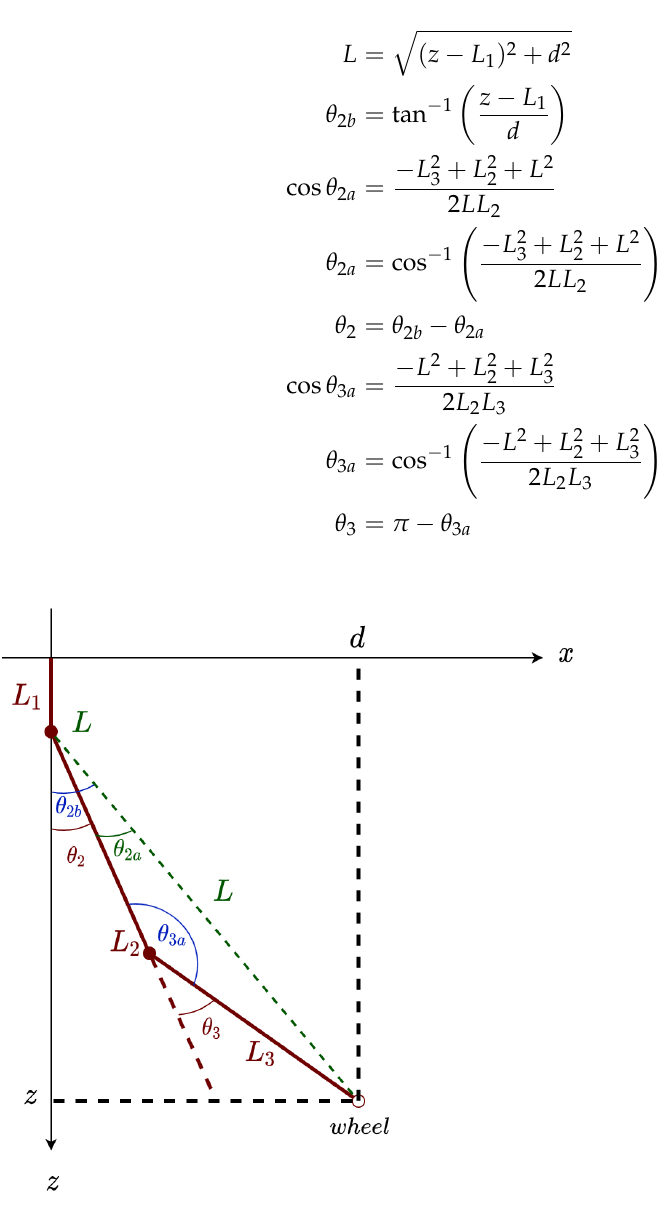
Figure 14. Inverse kinematics representation.